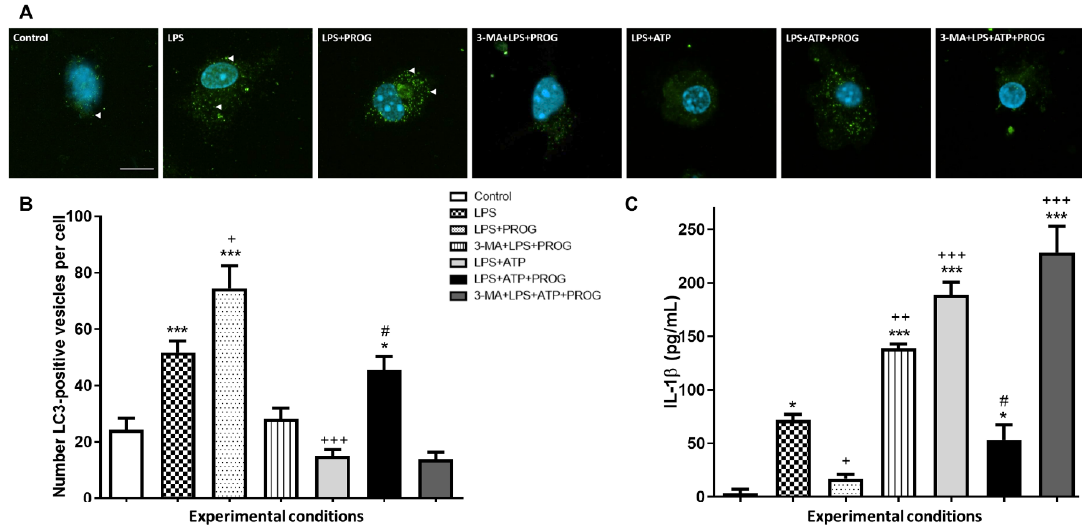
Figure 5. Inflammasome activation in vitro compromises autophagy in microglia. Primary cultured microglia were stimulated with LPS (1 μg/mL), followed by ATP (5 mM), and concomitantly treated with PROG (20 μM). Pre-treatment with 3-MA (5 mM) was used to inhibit autophagy. ( A ) Representative immunofluorescence for LC3-positive vesicles (white arrowheads) in microglia isolated from neonatal mice. ( B ) Average number of LC3-positive vesicles per cell in each condition [ANOVA F(6, 159) = 18.63, p < 0.0001] . ( C ) IL- 1β levels in the culture supernatant , as measured by ELISA [ANOVA F(6, 14) = 83.90, p < 0.0001] . Scale bar: 10 μm. Data are expressed as mean±SEM. N = 3 replications. * p < 0.05, *** p < 0.001